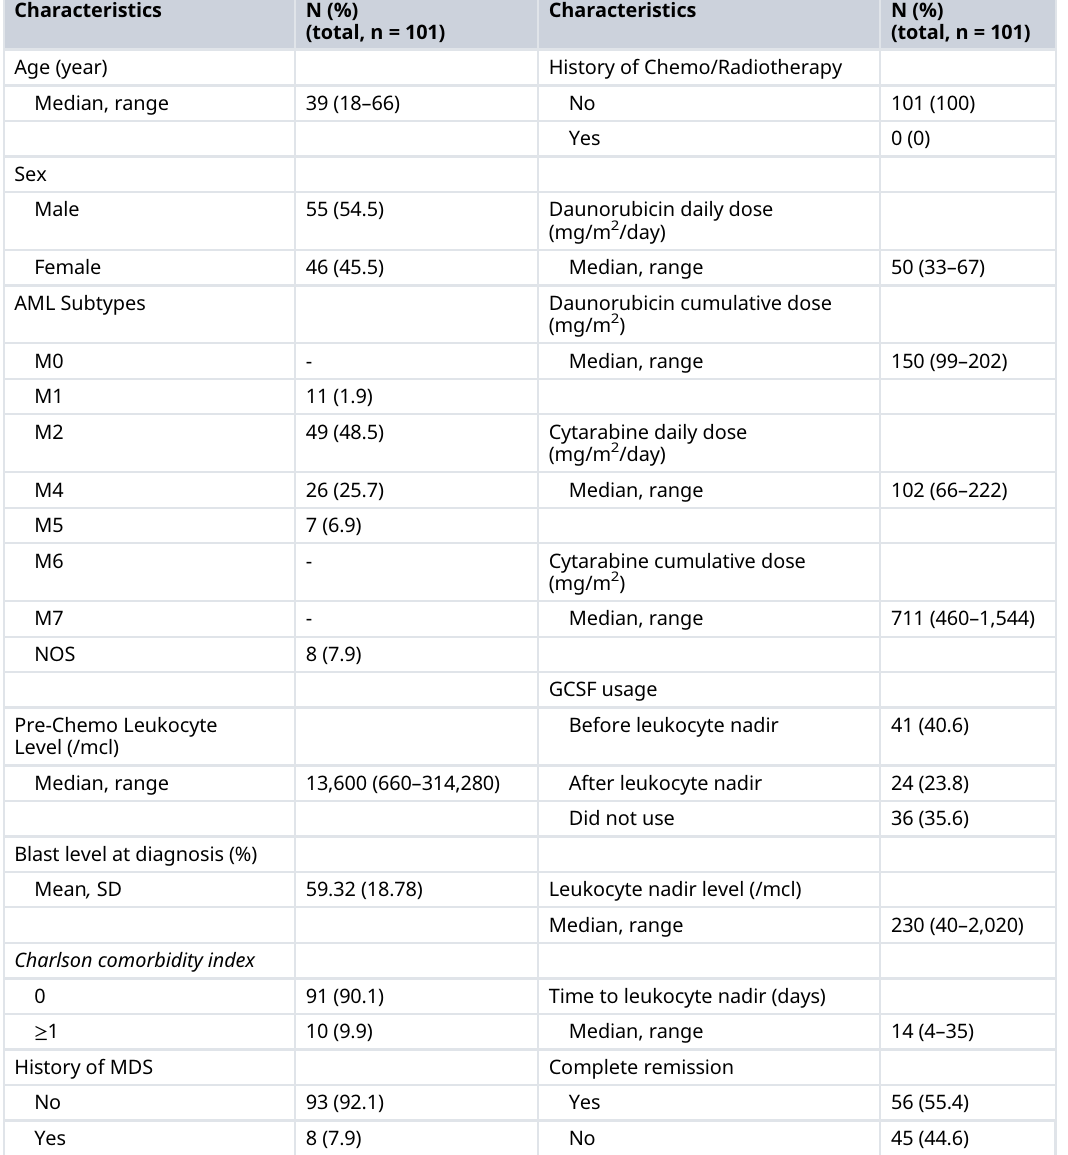
Table 1. Characteristics of research